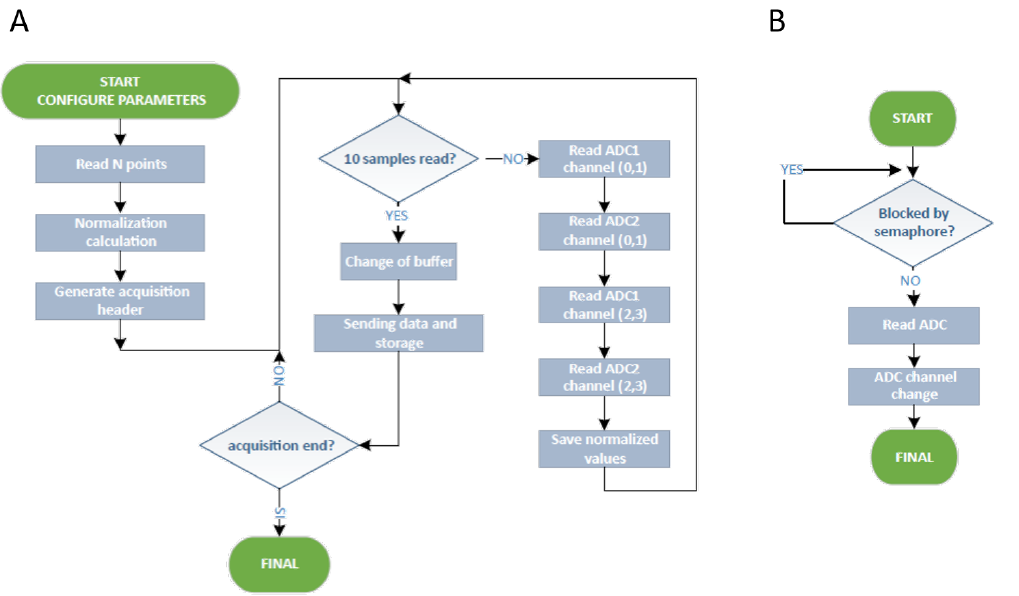
Figure 7. Flowchart of: ( A ) the data acquisition process; ( B ) data reading operation